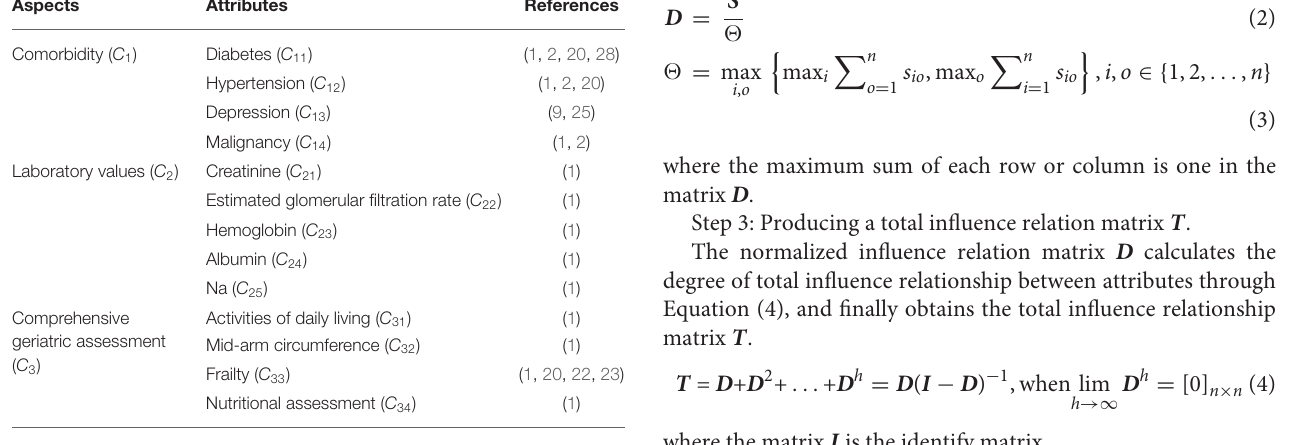
TABLE 1 | The AKI risk assessment framework.